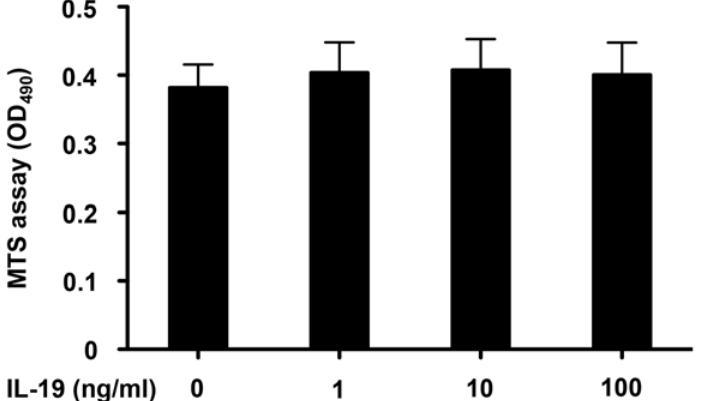
Fig 4. IL-19 does not affect microglial proliferation. Microglial proliferation was evaluated by MTS assay. Treatment with 1 – 100 ng/ml IL-19 for 24 h did not affect microglial proliferation. Values are means ± SD (n = 5).